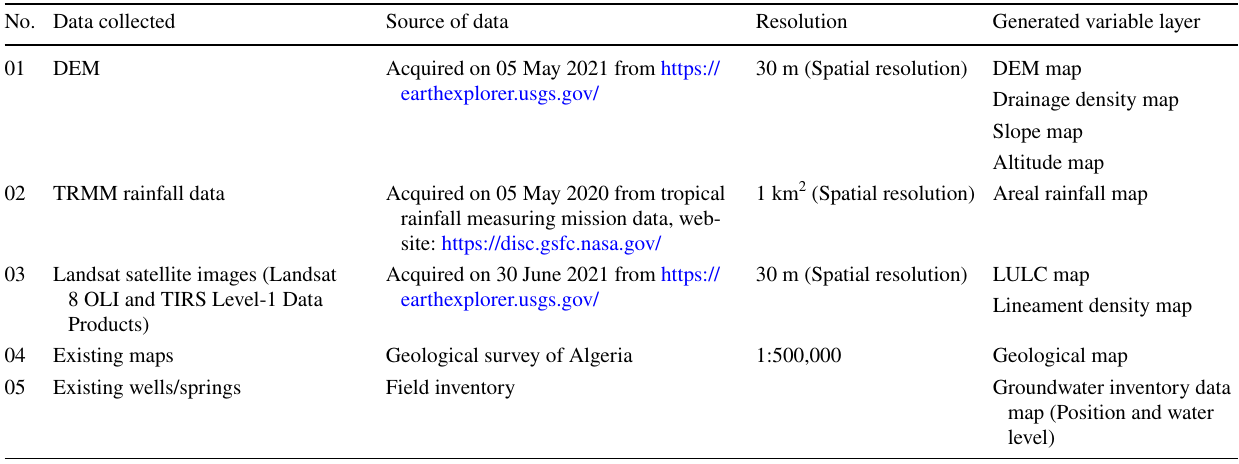
No. Data collected